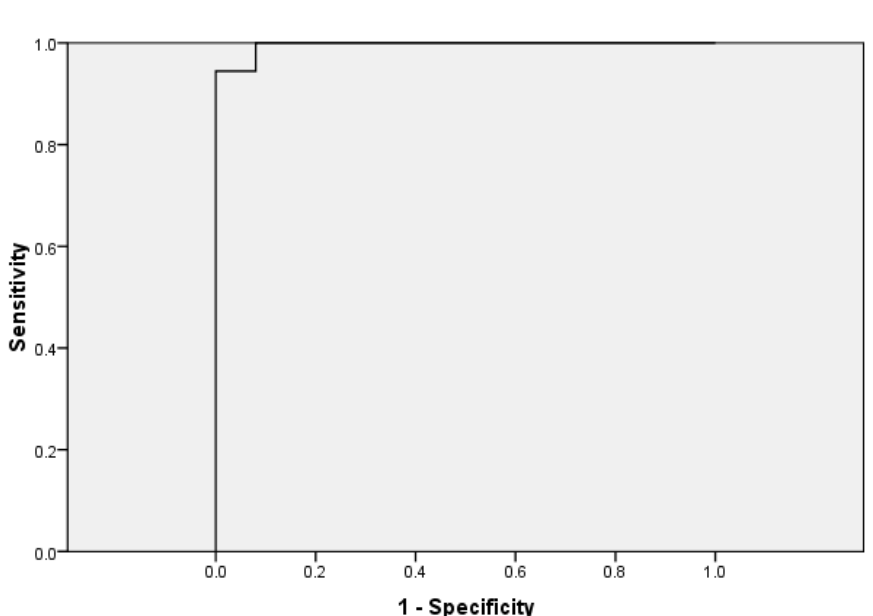
Figure 5. ROC curve of ADC values to differentiate malignant and benign lymphadenopathy. (AUC = 0.996; SE = 0.006; asymptotic significance < 0.001; 95% confidence interval 0–1.0). ROC; receiver operating characteristic, AUC; area under the curve, SE; standard error.